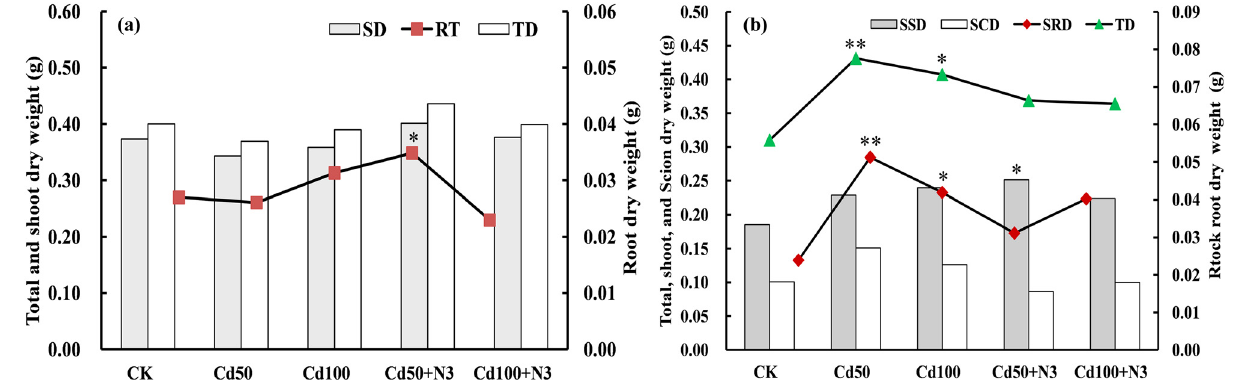
Figure 2: Shoot and root dry weights of ( a ) nongrafted and ( b ) grafted plants grown in substrates supplemented with 50 and 100 µM Cd. Signi fi cant di ff erences were tested at * p ≤ 0.05 and ** p ≤ 0.01. Values are the means ± standard deviations of three replicates. SD, shoot dry weight; RT, root dry weight; TD, total dry weight; SSD, rootstock shoot dry weight; SCD, scion dry weight; SRD, rootstock root dry weight.